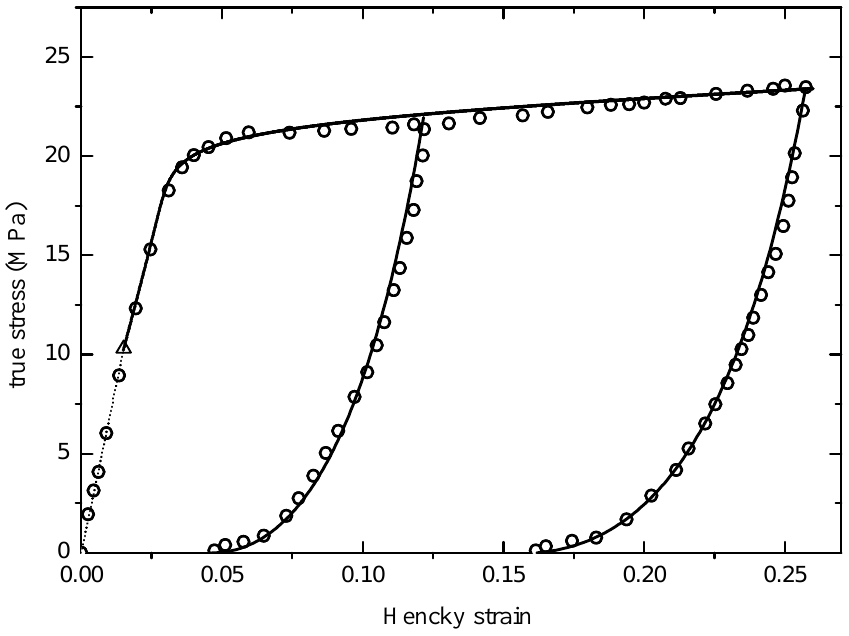
Figure 2. Fitting the data in [27] for SMP